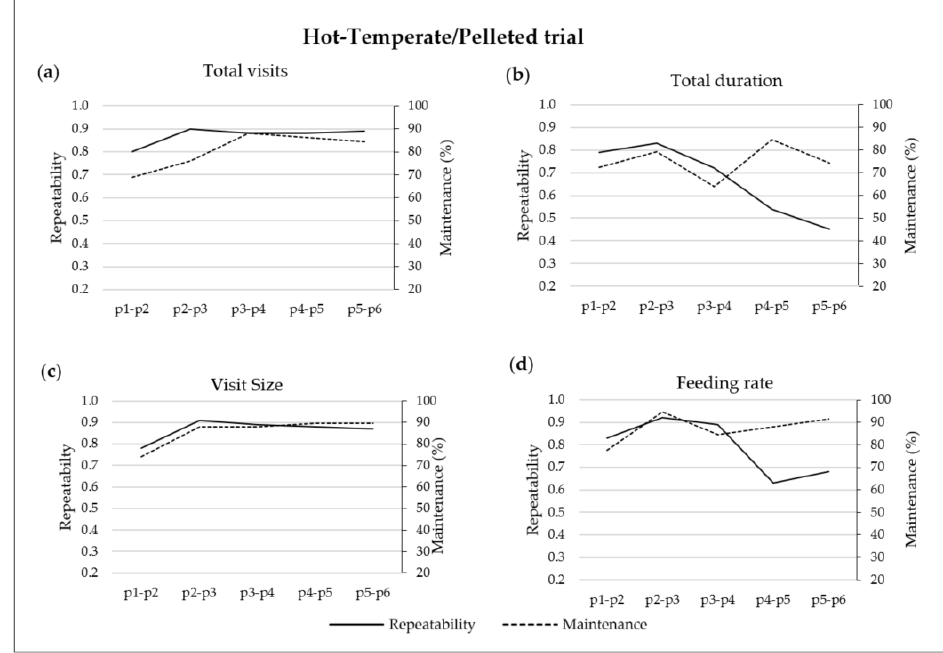
Figure 2. Repeatability (left axis) and maintenance (right axis) of ( a ) total visits, ( b ) total duration, ( c ) visit size and ( d ) feeding rate over two consecutive 14-day periods from p1 to p6 (six periods of 14 days each from day 31 to day 114 of fattening) in the Hot-Temperate/Pelleted trial (the average temperatures were of 30.7 and 21.2 °C on day 31 and on day 114 of fattening).